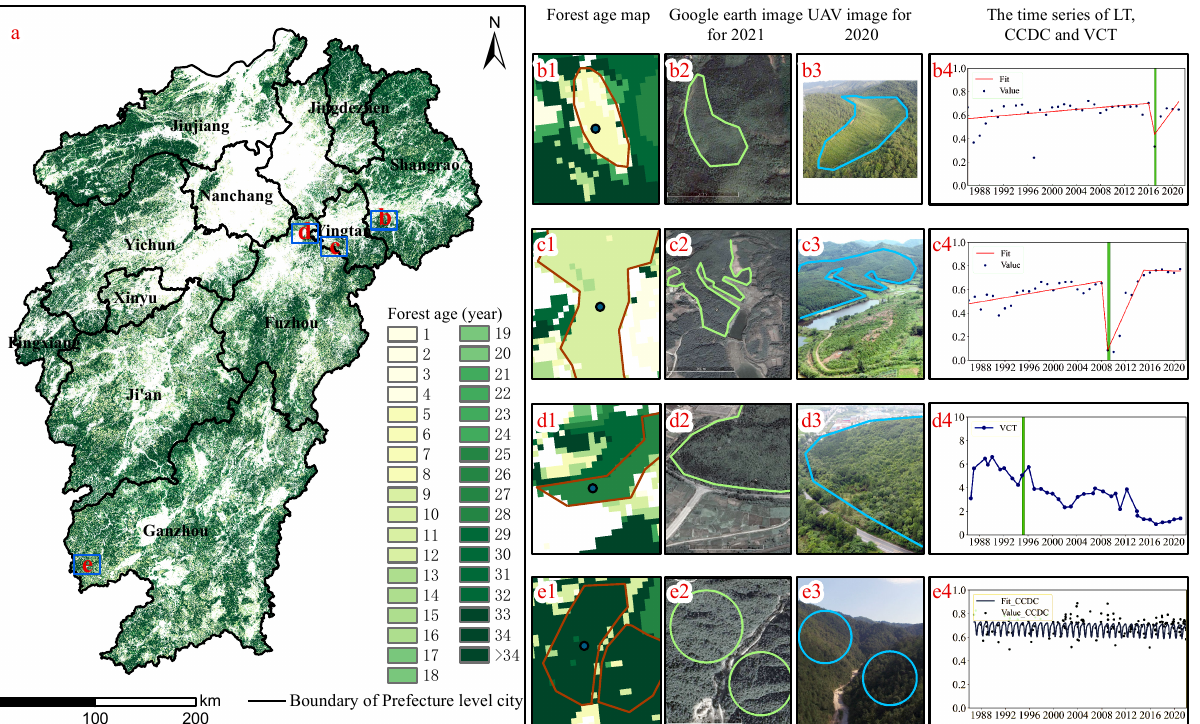
Figure 7. ( a ): The spatial distribution of SFA in Jiangxi province in 2021; ( b – e ) presents the types of younger, middle-aged, premature forests, and mature forests. The no 1–4 in ( b – e ) presents the age results, Google earth images, unmanned aerial vehicle (UAV) images, and time series from the individual algorithms,